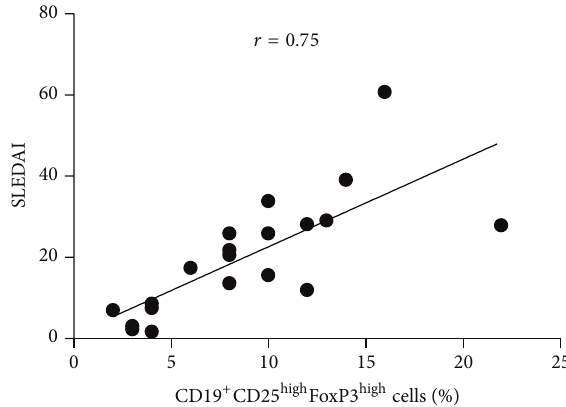
Figure 4: Clinical correlation between the percentage of CD 19 + CD 25 high FoxP 3 high cells of SLE patients and the SLEDAI score of these patients. The correlation was done using the Pearson correlation